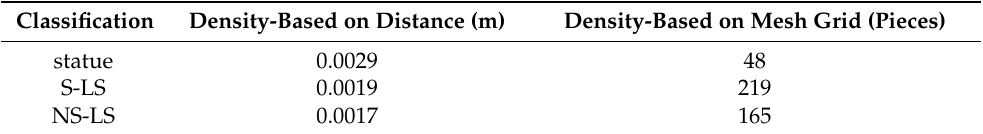
Table 1. The experimental data’s point cloud